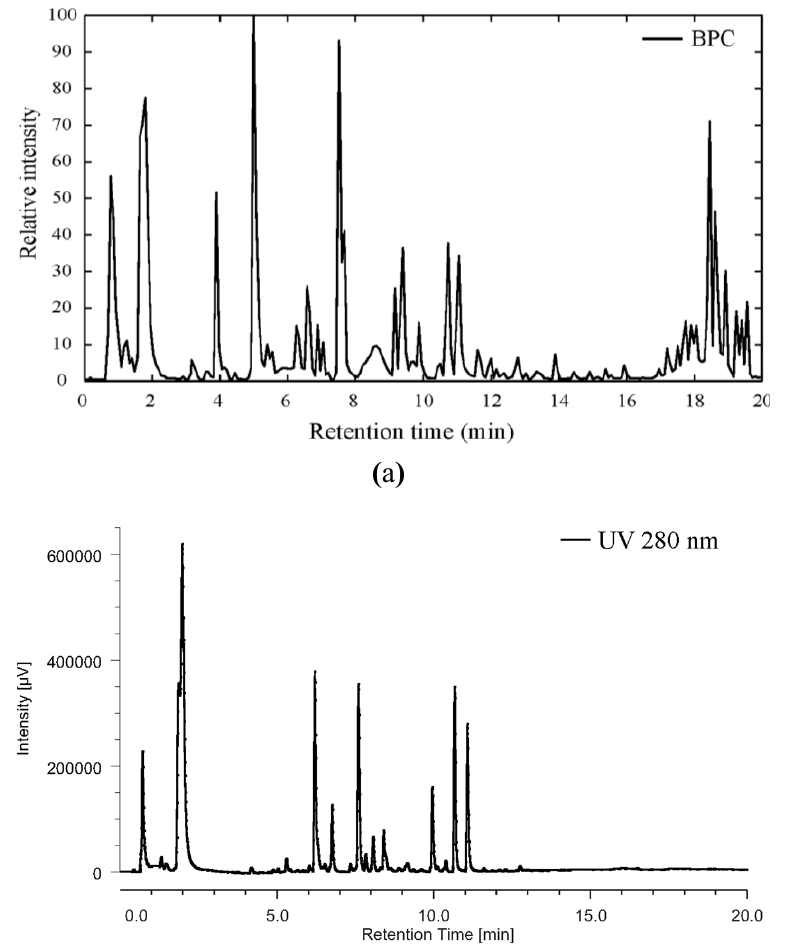
Figure 7. BPC ( a ), UV ( b ) and ECD ( c ) profiles of the crude extract of Parazoanthus axinellae